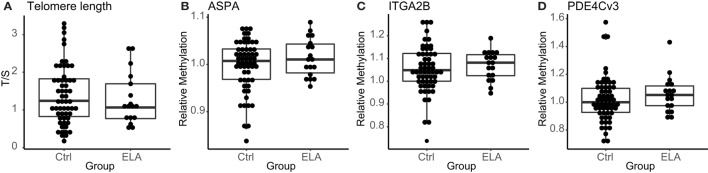
Markers for senescence. Relative telomere length in T/S (A), methylation levels at the age-related CpGs ASPA, ITGA2B, and PDE4C (B–D), respectively. Statistics: Wilcoxon rank sum test with continuity correction. Abbreviations: Ctrl, control; ASPA, aspartoacylase; ELA, early life adversity; ITGA2B, integrin alpha 2b; PDE4C, phosphodiesterase; T/S, relative telomere to single copy gene ratio.